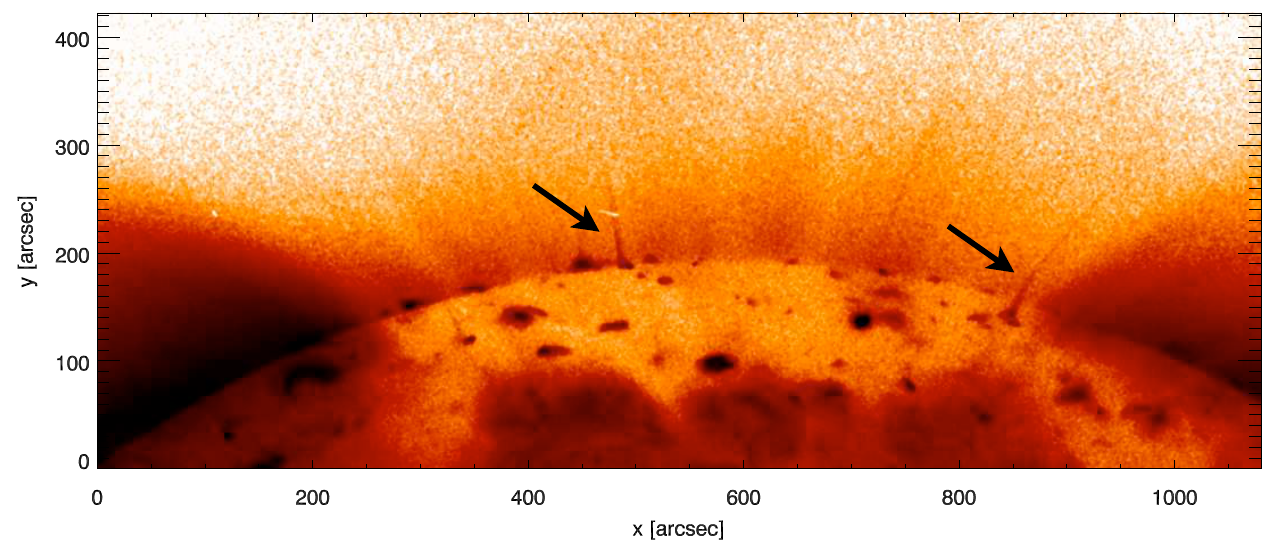
Fig. 9. Image taken by the X-Ray Telescope XRT on board Hinode on January 10, 2007 using the Al/Poly filter. The dark shading corresponds to high intensity, the light shading to low intensity. The arrows indicate two elongated structures inside the coronal hole which show jetting activity. XRT photo credit: